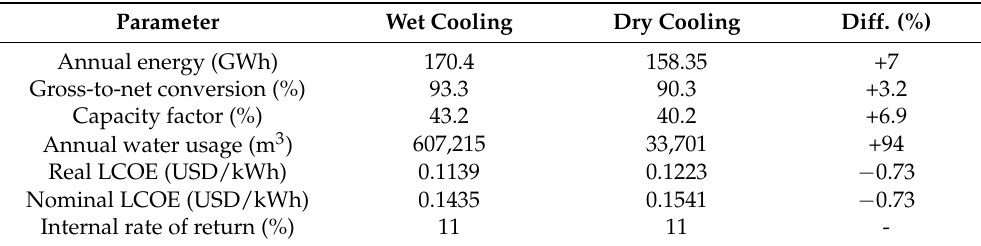
Table 4. Results of simulations for the investigated PTC plant for both cooling modes.